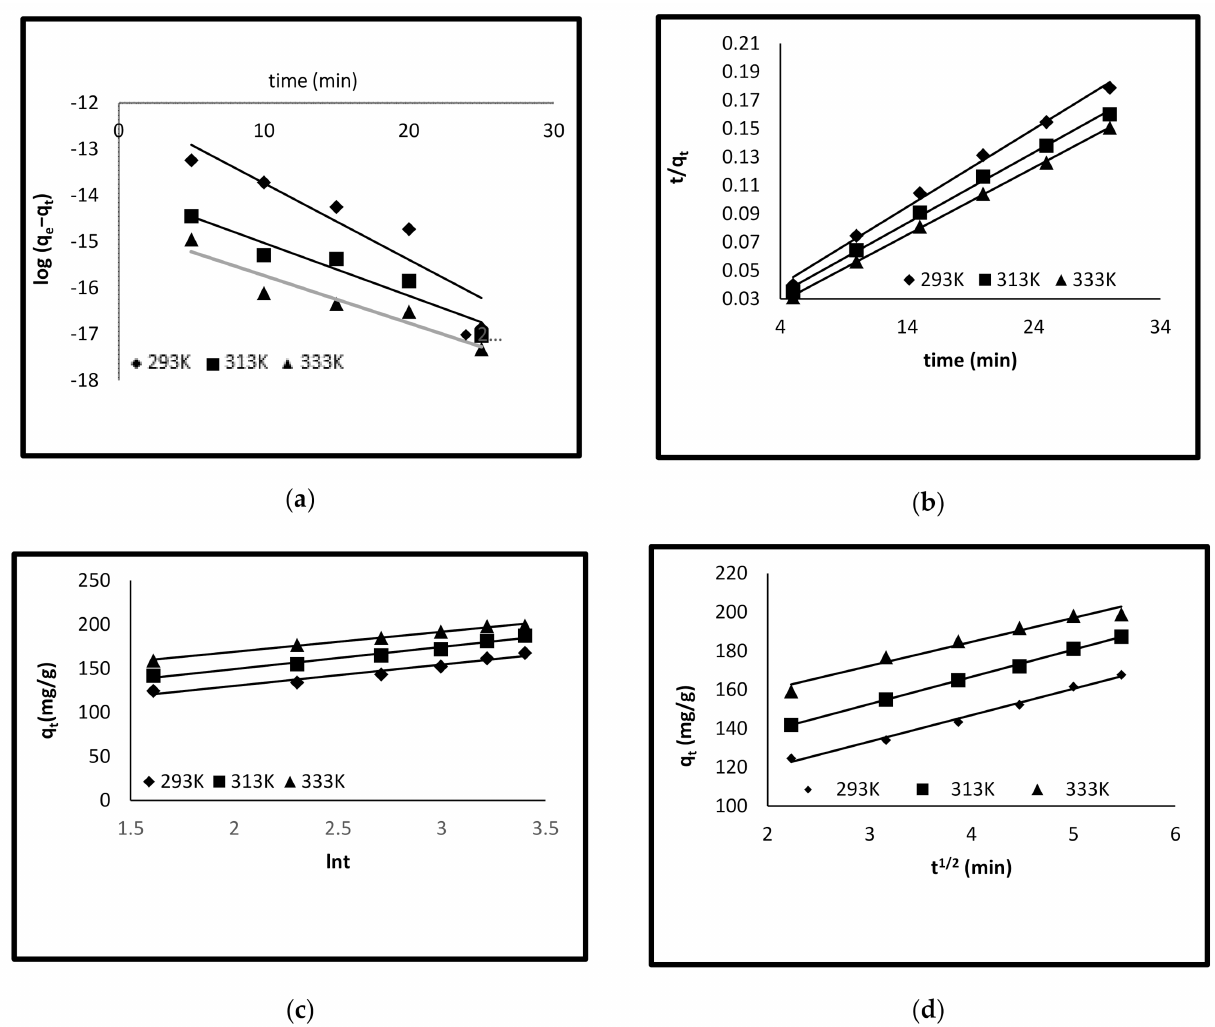
Figure 8. Kinetic models for adsorption of AO-8 on Pd-Ni/AC-CeO 2 . ( a ) Pseudo 1 st order kinetics. ( b ) Pseudo 2nd order kinetics. ( c ) Elovich model. ( d ) Intra particle diffusion